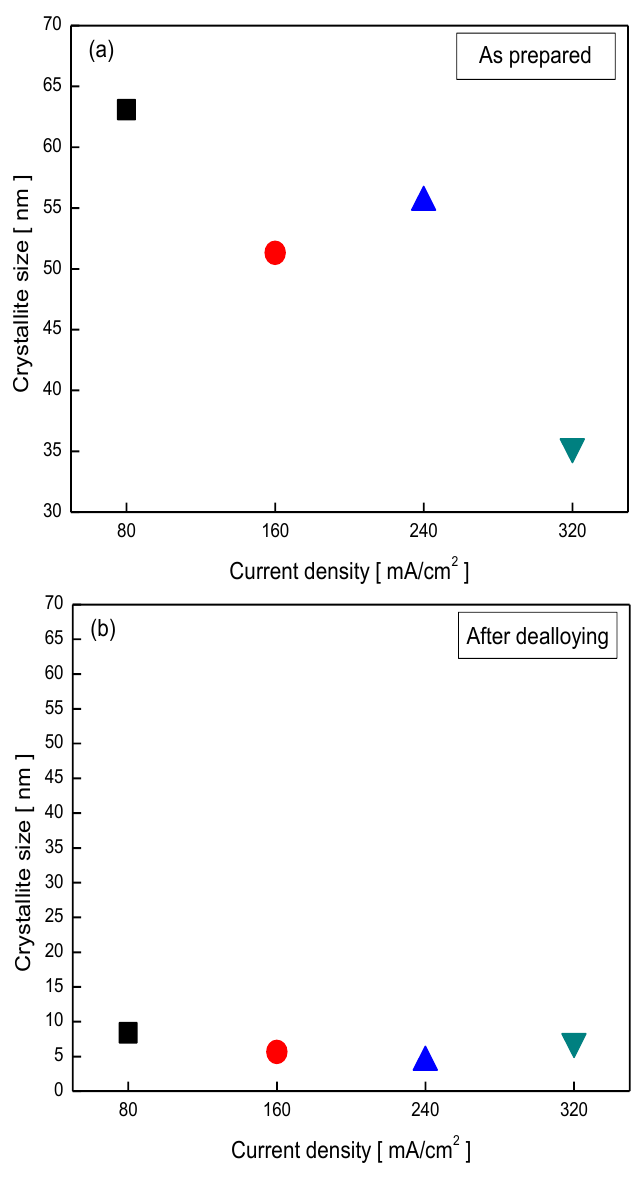
Figure 2. Ni(111) crystallite size of electrodeposited Ni–Zn–Fe on Ni foam prepared by different current density in the bath (E) ( a ) as prepared ( b ) after dealloying.